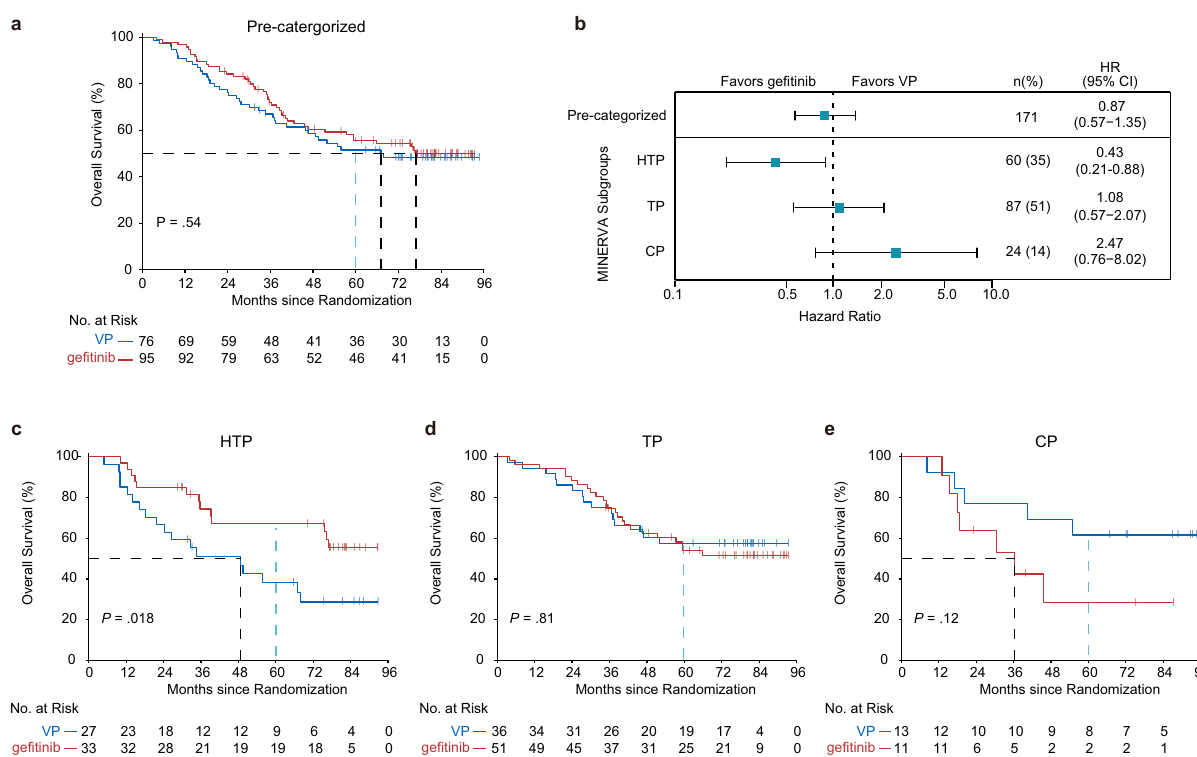
Fig. 3 Overall survival (OS) bene fi t strati fi cation by MINERVA. a Kaplan – Meier estimates of OS for the pre-categorized cohort included in this study ( N = 171). Two-sided P value was calculated using log-rank test. b Forest plot showing hazard ratio (HR) of OS in MINERVA subgroups. Error bars indicate 95% con fi dence intervals. c – e Kaplan-Meier curves estimate OS in each subgroup by treatments. Dotted lines in black indicate median OS. Dotted lines in blue indicate 5-year survival rate (60 months). Two-sided P values were derived from the log-rank